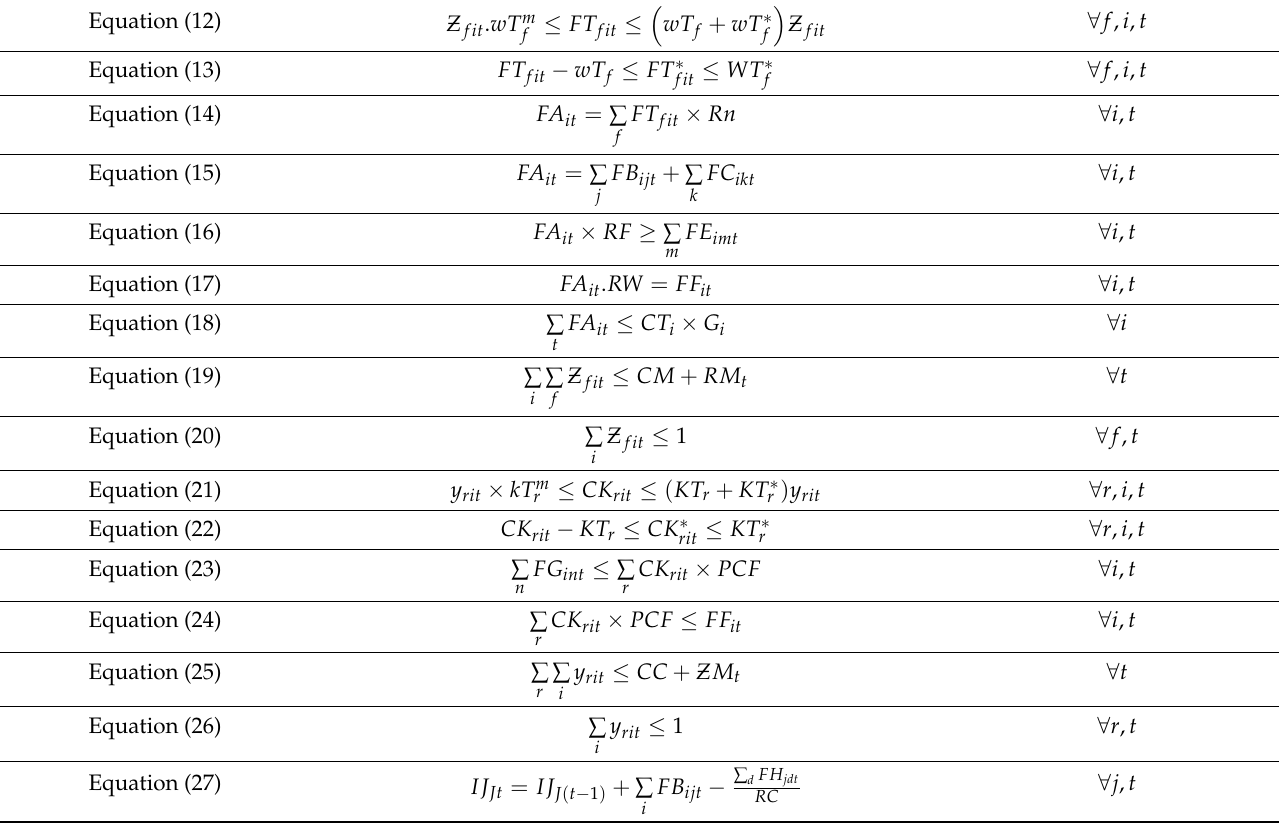
Table 4. Constraints of mathematical